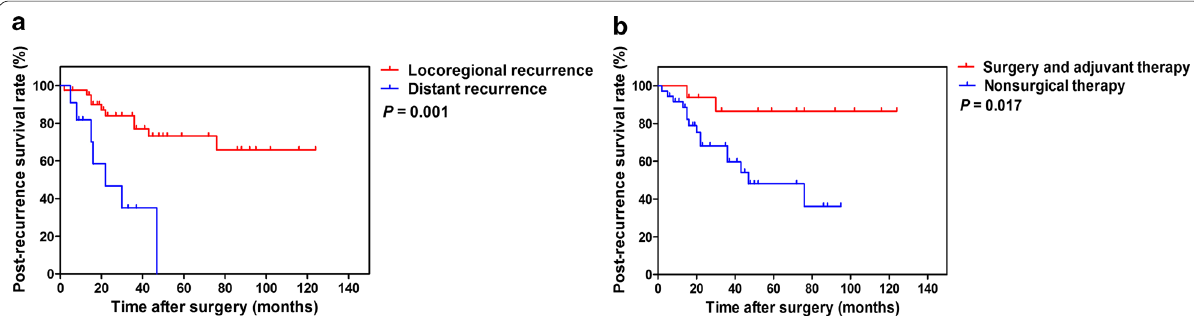
Fig. 2 Kaplan–Meier analysis of post‑recurrence survival curves for patients with recurrent thymoma. a Post‑recurrence survival curves stratified according to the recurrence pattern. b Post‑recurrence survival curves stratified according to the type of